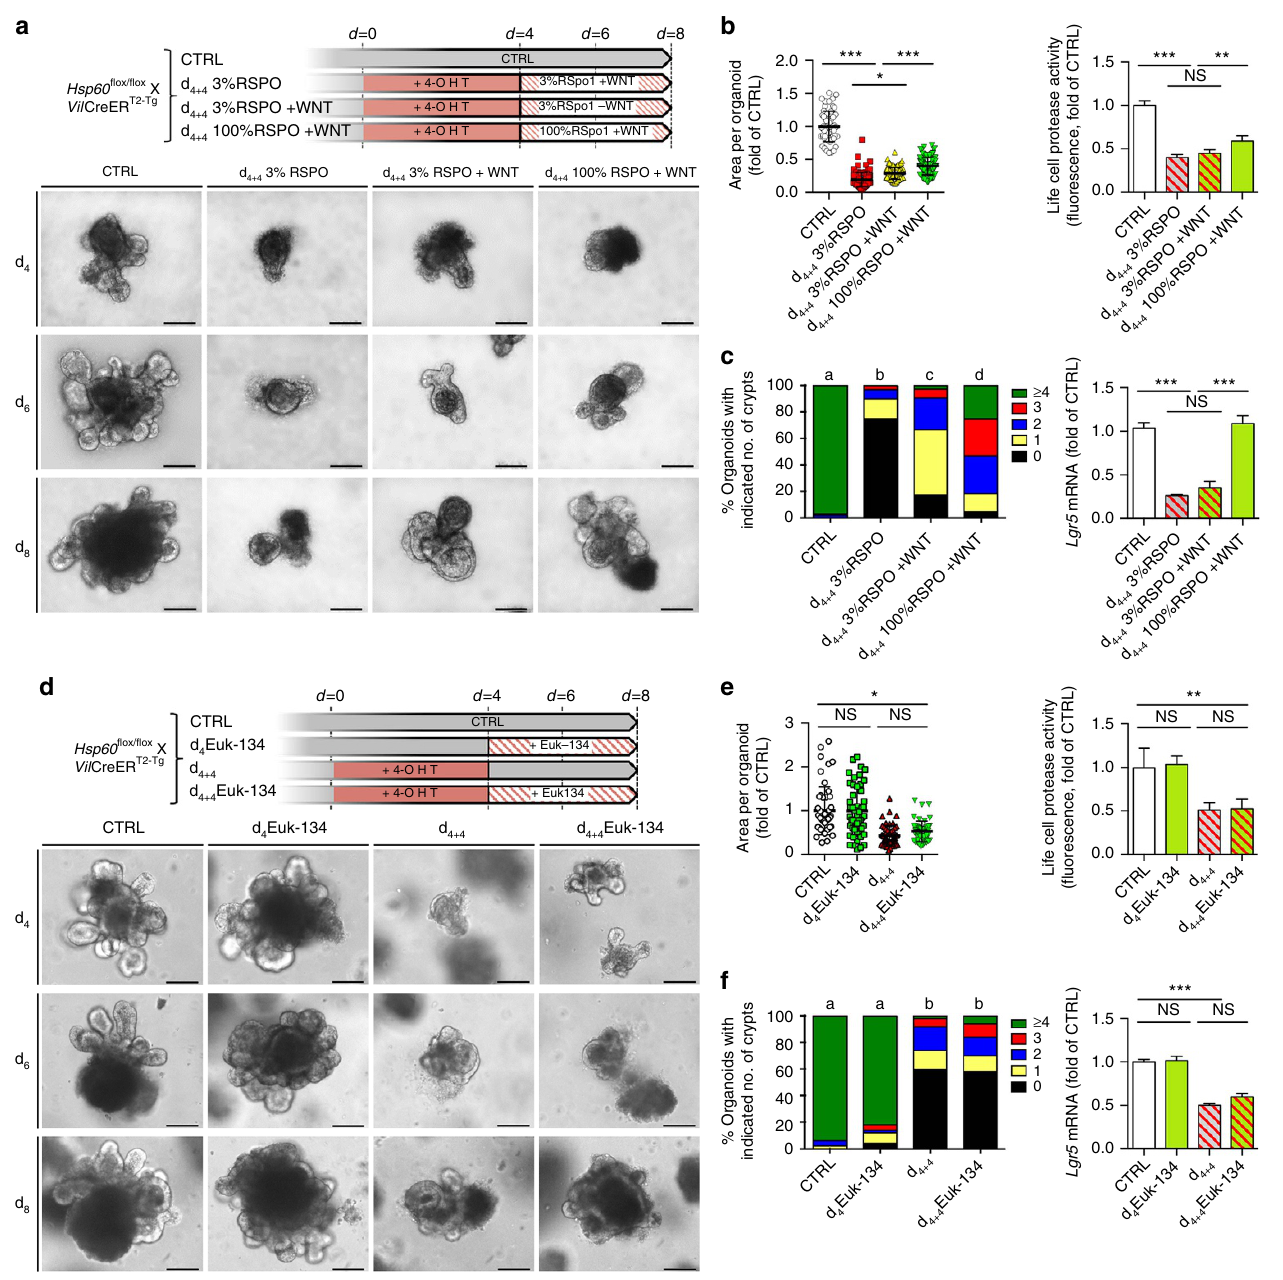
Figure 9 | WNT10A and RSPO1 but not ROS scavenging rescues intestinal organoid growth after Hsp60 knockout. Organoids were isolated from Hsp60 flox/flox , Villin CreER T2-Tg mice and distributed to four protocols. ( a ) Experimental scheme to show the effects of RSPO1 and WNT10A supplementation (100ngml (cid:2) 1 ) on Hsp60-deficient small intestinal organoids. Lower panel: representative pictures of the indicated treatments and time points. ( b ) Measurement of organoid area (left; N 4 60 per treatment) and life cell protease activity measured by fluorescence (right) following indicated treatments. ( c ) Quantification of de novo crypt formation (left); (a–d) significantly different from each other, Kruskal–Wallis test on ranks followed by Dunn’s test. Right: qRT–PCR analysis of Lgr5 mRNA expression in organoids in response to WNT10A treatment. ( d ) Experimental scheme to show the effects of the ROS scavenger Euk-134 (100 m M) on Hsp60-deficient small intestinal organoids. Lower panel: representative pictures of the indicated treatments and time points. ( e ) Organoid area (left; N 4 60 per treatment) and life cell protease activity measured by fluorescence (right) following indicated treatments. ( f ) Quantification of de novo crypt formation (left); (a,b), significantly different from each other, Kruskal–Wallis test on ranks followed by Dunn’s test. Right: qRT–PCR analysis of Lgr5 mRNA expression in organoids in response to Euk-134 treatment. Bars represent mean þ s.e.m. Asterisks indicate significant differences * P o 0.05; ** P o 0.01; *** P o 0.001; NS, not significant. Unless otherwise indicated, one-way analysis of variance and appropriate post hoc tests were used for all statistical analyses. Data from organoid experiments derive from at least three independent experiments. Scale bars, 200 m